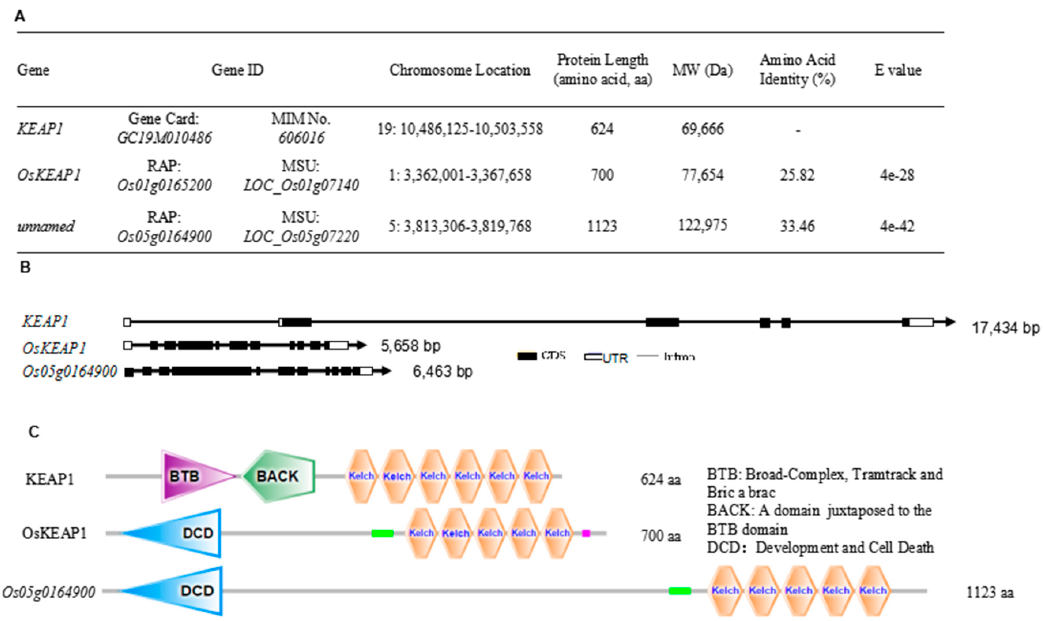
Figure 1. Gene information ( A ), structure ( B ), and protein features ( C ) of human KEAP1 and its orthologs in rice. Prediction of domains was performed at https://smart.embl.de/. The green and pink/red boxes represent the coiled-coil region and low complex region, respectively.